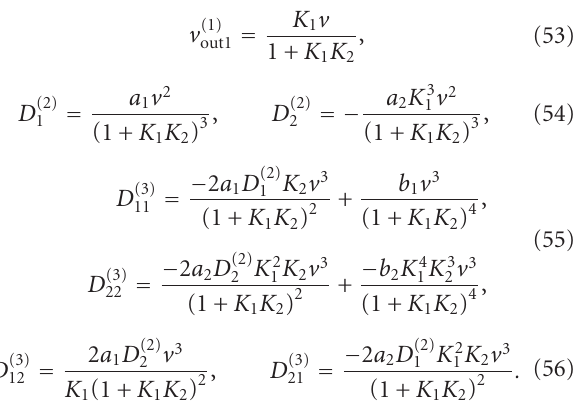
Figure 2: The amplifier with feedback